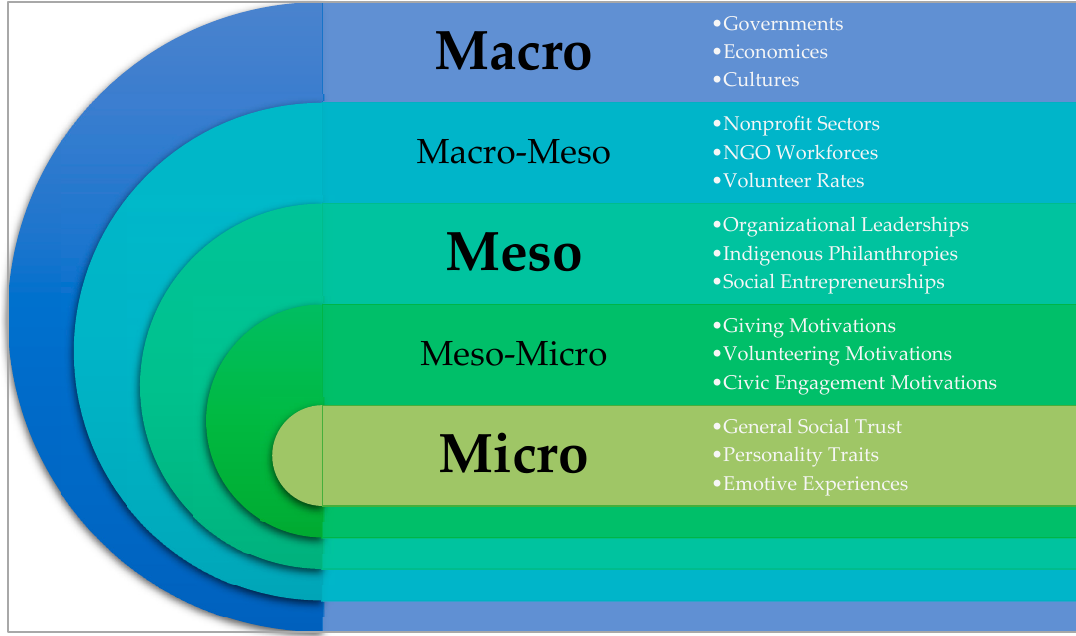
Figure 1. Visual of macro, meso, and micro levels of analysis with example topics. Source: Author created. NGO: nongovernmental organization.